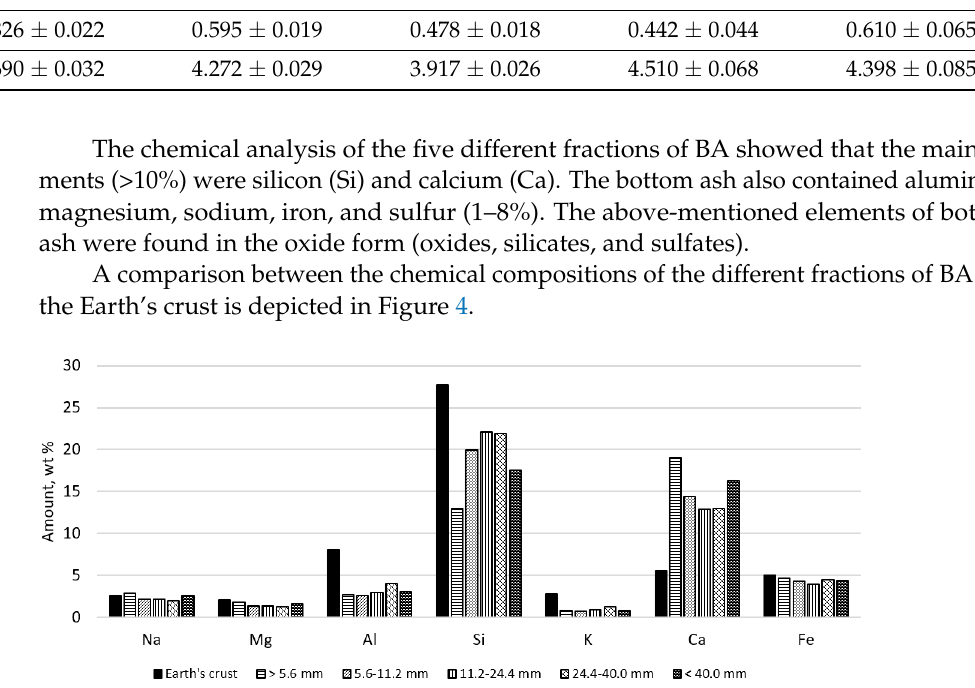
Figure 4. Major chemical elements of MSWI BA in comparison to the element abundances in the Earth’s crust, based on [27].